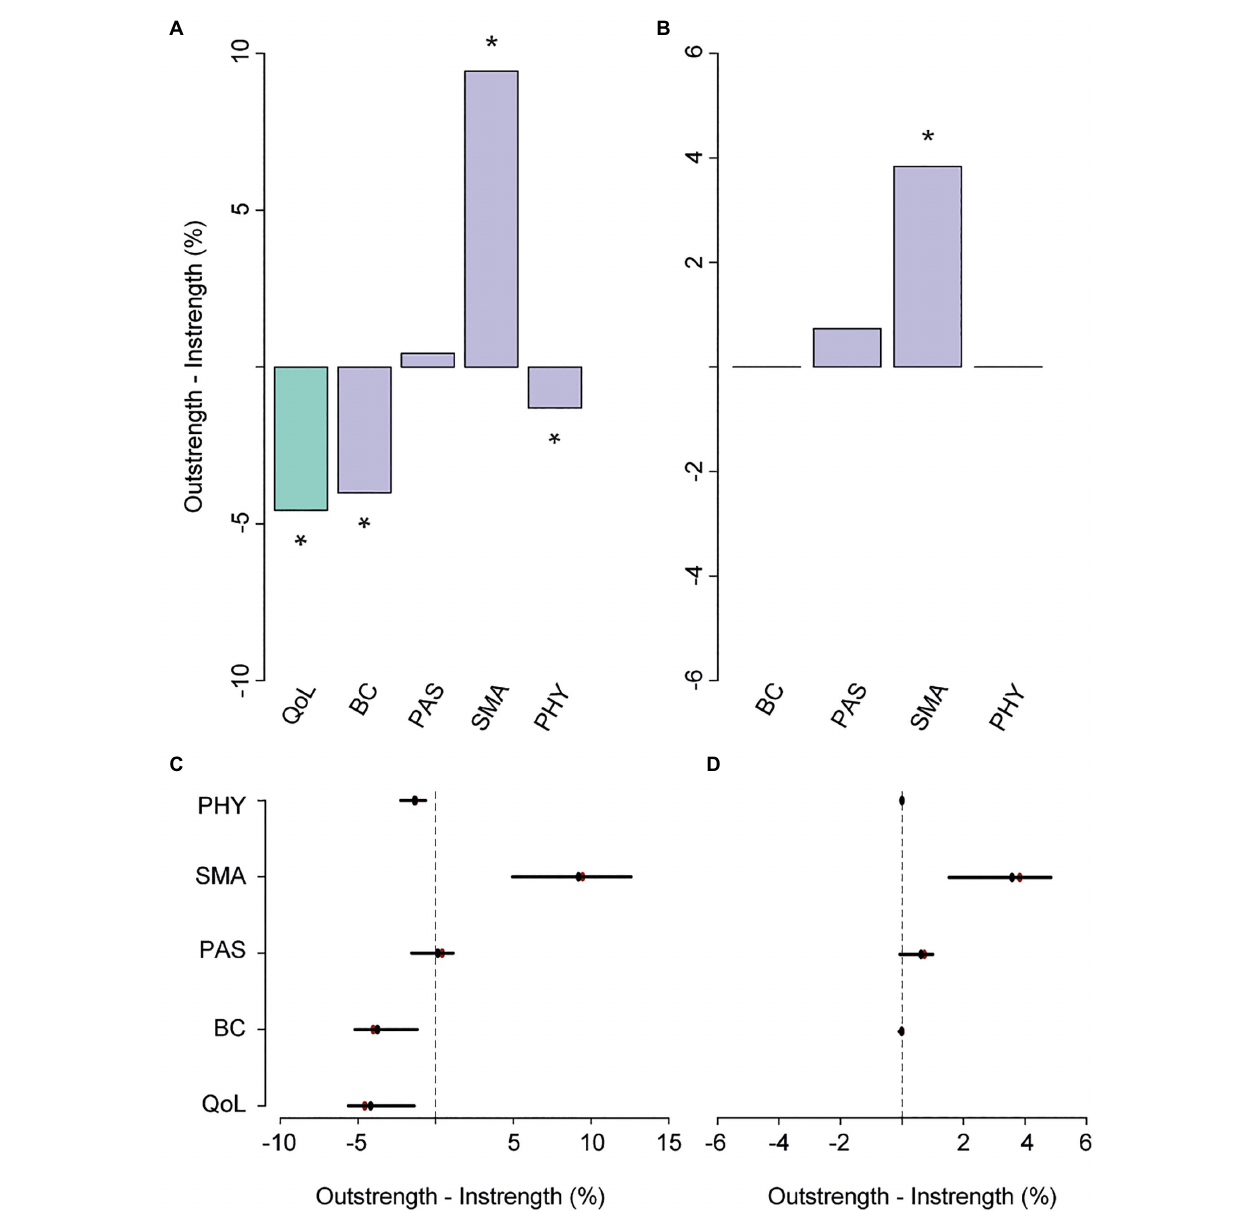
FIGURE 2 | The difference between overall outstrength and instrength of the nodes in the primary network (A) and the difference in outstrength and instrength of the relationships between the resilience factors and QoL only (B) . Colors of the bar charts correspond to the nodes in the network in Figure 1 . In plots (C,D) , the bootstrapped mean is depicted in black and the sample mean in red. * p < 0.05; nodes with quantile intervals containing zero are deemed to have an insignificant instrength and outstrength